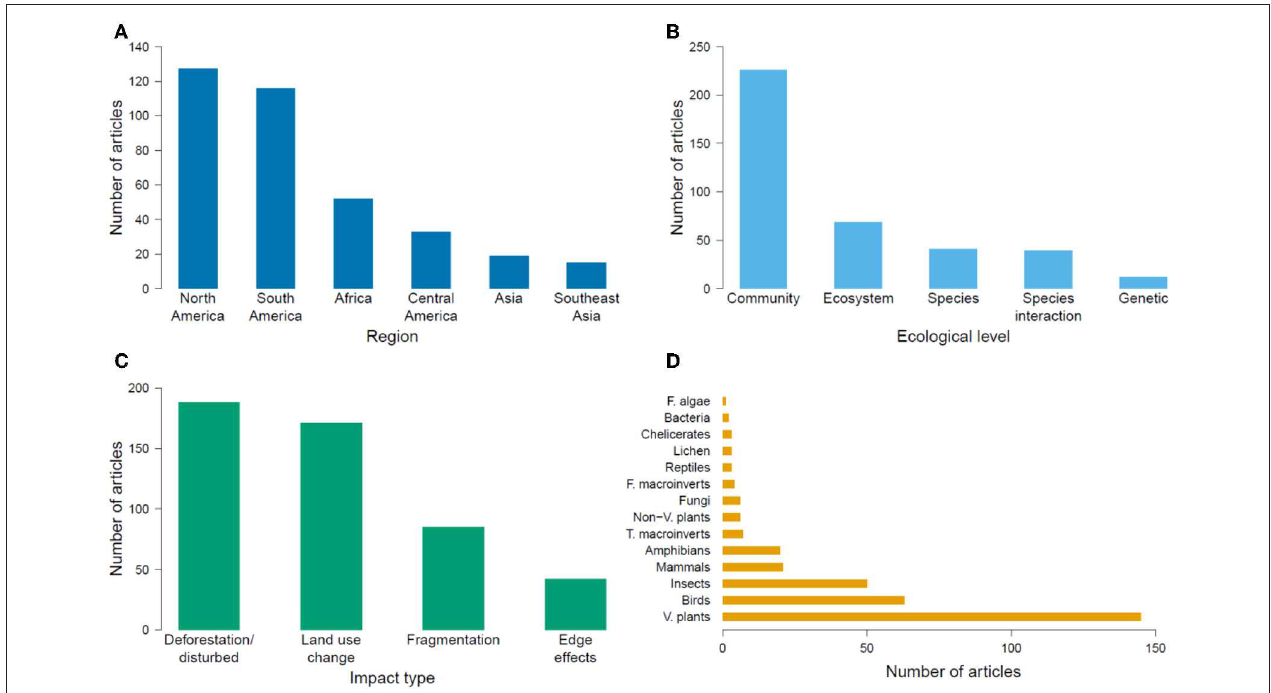
FIGURE 2 | Number of articles published globally from 1991 to 2018 on the impacts of habitat degradation on tropical montane biodiversity in different (A) geographical regions, (B) ecological levels, (C) impact types, and (D) taxonomic groups. F, T, and V refer to freshwater, terrestrial, and vascular respectively.